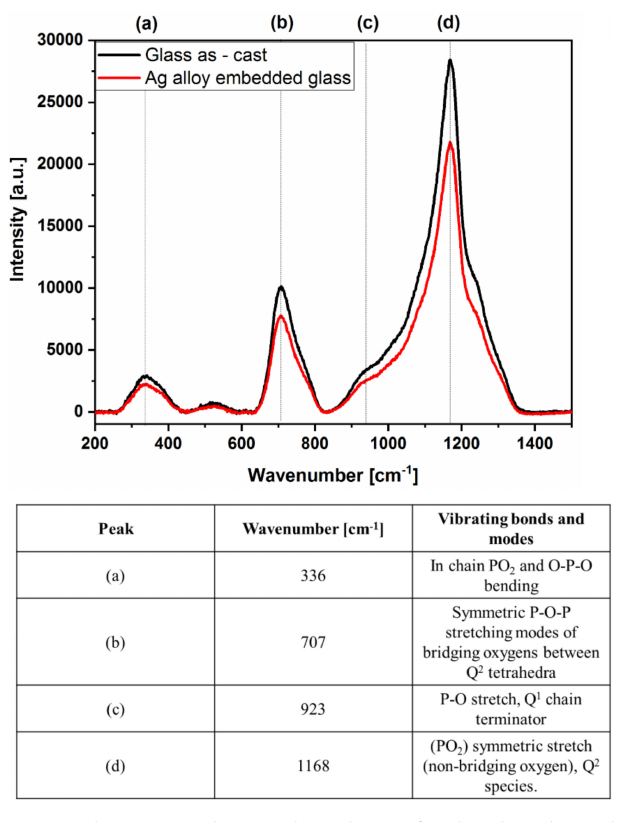
Figure 8. Raman spectra and corresponding peaks indexing for the phosphate glass before and after casting the silver alloy around